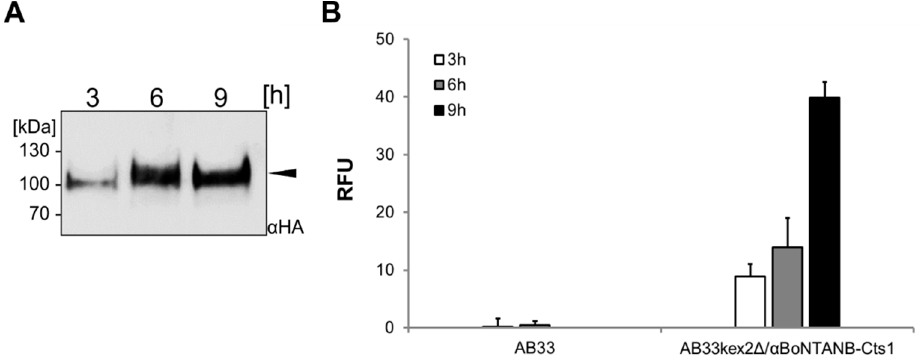
Figure 7. Optimization of α BoNTA nanobody expression. ( A ) Precipitated cell-free culture supernatants after different times of incubation. The full length fusion protein is depicted with a black arrowhead. Identical volumes of a single culture were analyzed; ( B ) Supernatant samples harvested at indicated time points were subjected to ELISA against BoNTA (biological triplicates). RFU, relative fluorescence units.